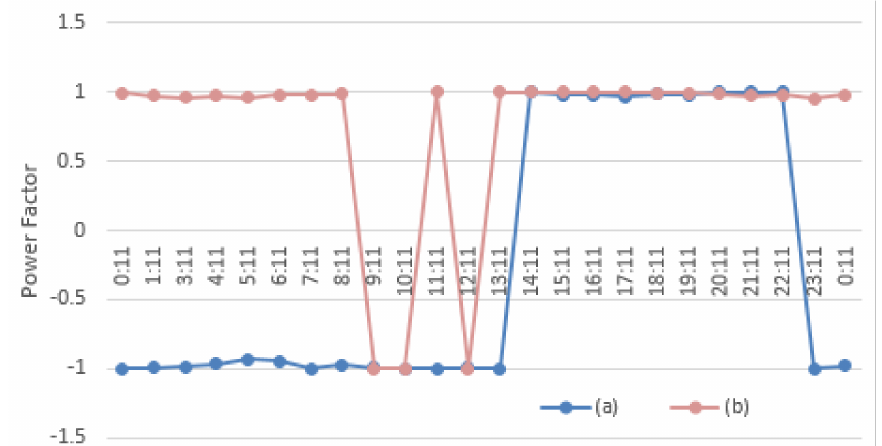
Figure 10. Transformer power factor (PF) after applying the first optimization procedure on the